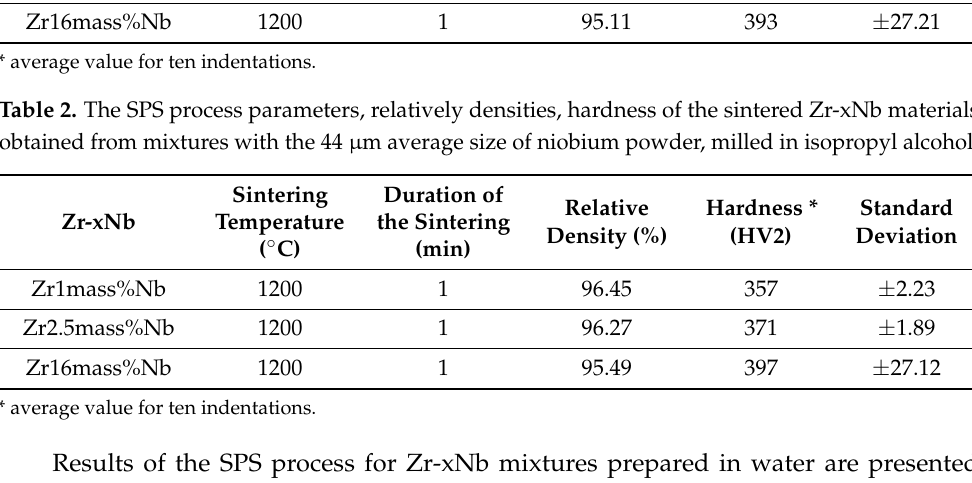
Table 2. The SPS process parameters, relatively densities, hardness of the sintered Zr-xNb materials obtained from mixtures with the 44 µ m average size of niobium powder, milled in isopropyl alcohol.